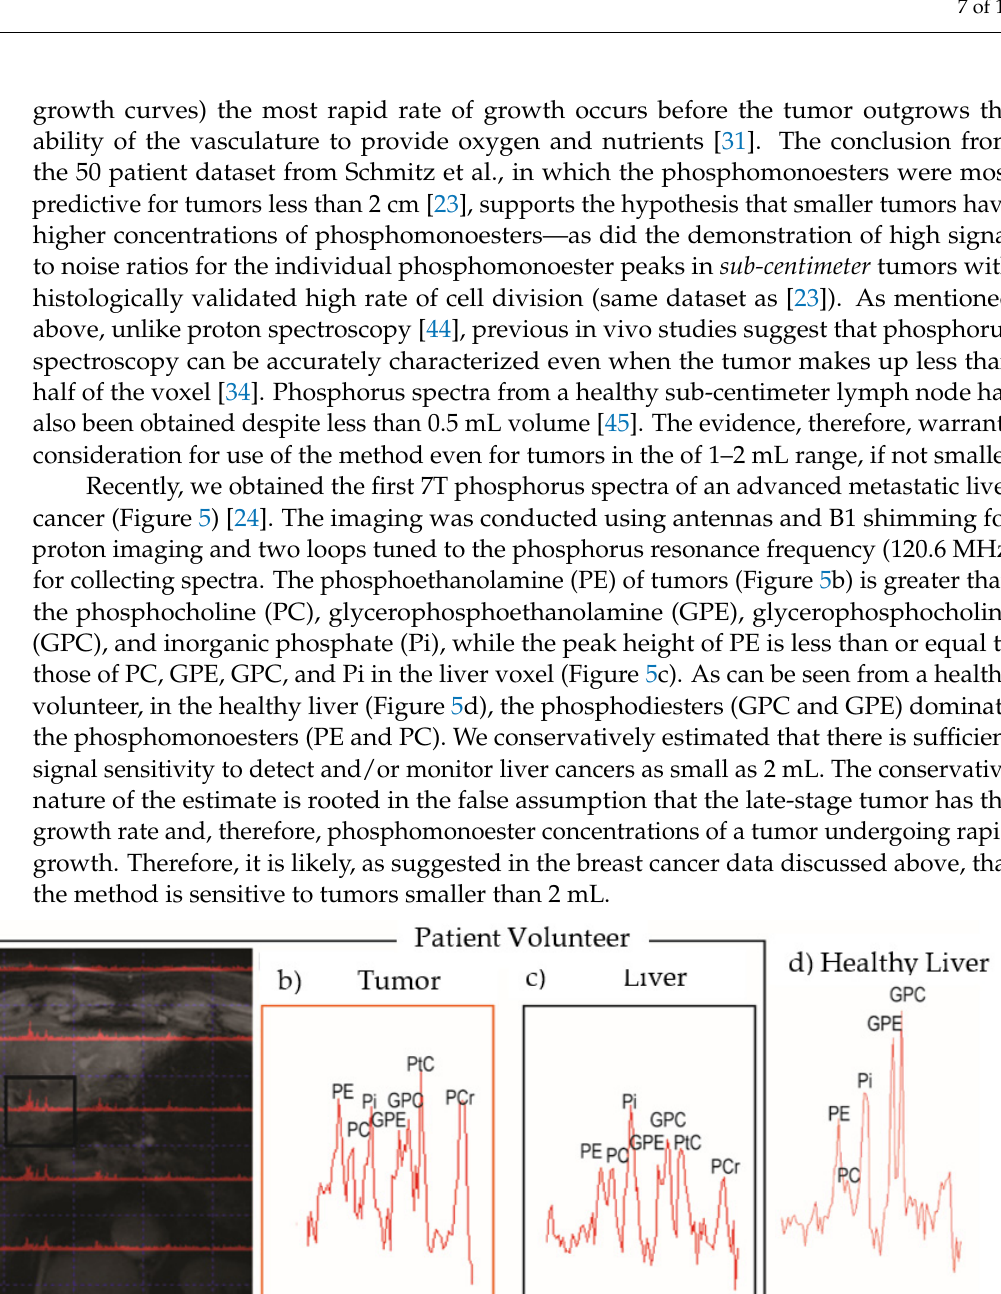
Figure 5. Images and phosphorus spectroscopy obtained at 7T field strength from healthy and patient volunteers. ( a ) Phosphorus spectra 3D chemical shift imaging with 30 mm isotropic voxels from a patient with liver metastasis (gastric primary), displayed on a B1-shimmed Dixon image obtained with eight antennas. Red square and black square correspond to tumor and liver tissue respectively. Spectroscopic data from a patient with one average ( b ) and ( c ) and from a healthy volunteer ( d ) with five averages, scaled to the Pi peak. PE, phosphoethanolamine; PC, phosphocholine; Pi, inorganic phosphate; GPE, glycosylated PE; GPC, glycosylated PC; PtC, phosphotidylcholine, PCr, phosphocreatine. Note that the chemical shift is expressed as parts per million (ppm) shift relative to phosphocreatine, which is circa 120.6 MHz at 7T. Images adapted from Rivera et al.